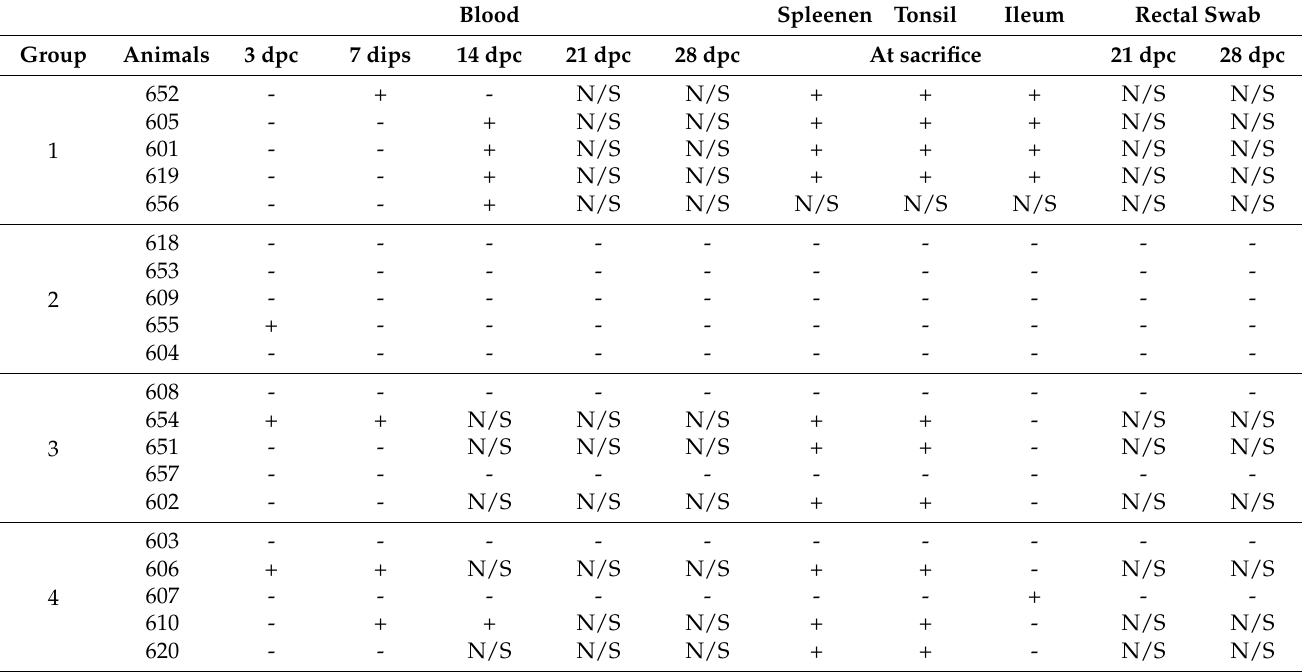
Table 1. Viral isolation. Group 1: unvaccinated animals. Group 2: animals immunized once five days before challenge. Group 3: animals immunized once three days before challenge. Group 4: animals immunized once one day before challenge.